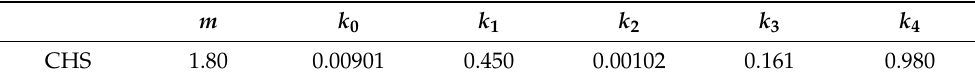
Figure 4. Procedure for the determination of the parameters of the models. Table 2. Value of the parameters of the models.